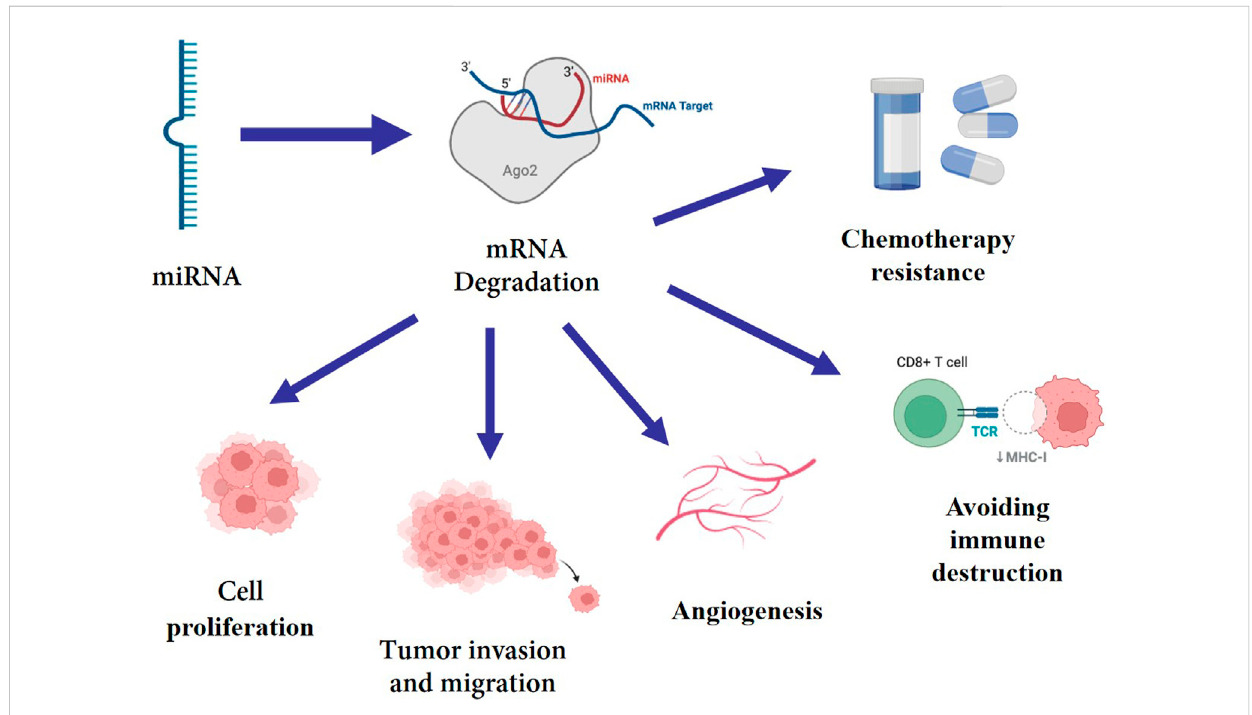
FIGURE 1 miRNA targets mRNA, mediating its degradation, which enhance cell proliferation, tumor invasion, migration, angiogenesis, immune evasion and chemotherapy